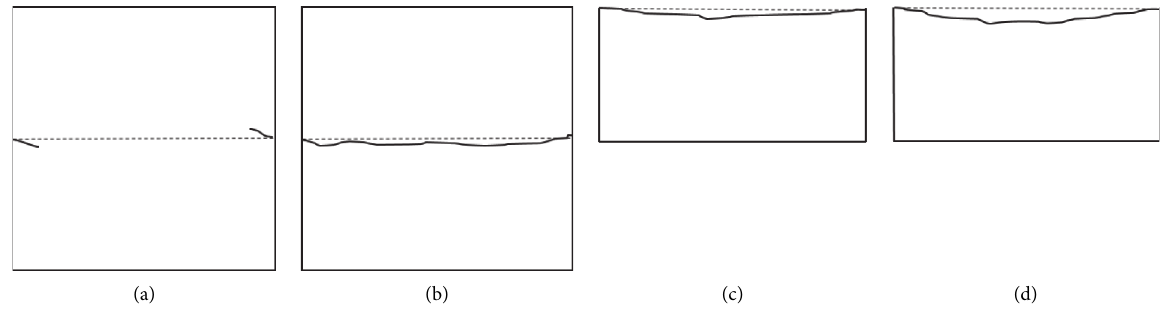
Figure 8: Shear failure modes of concrete in different stages. (a) Initial failure mode, (b) final failure mode, (c) 0% failure section, and (d) 40% failure